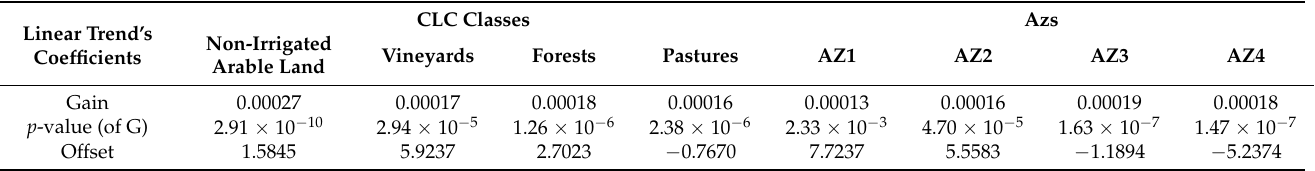
Table 7. Gain values of linear regression trends modelling daily average temperature between 2001 and 2019 for CLC and AZs classes used in this